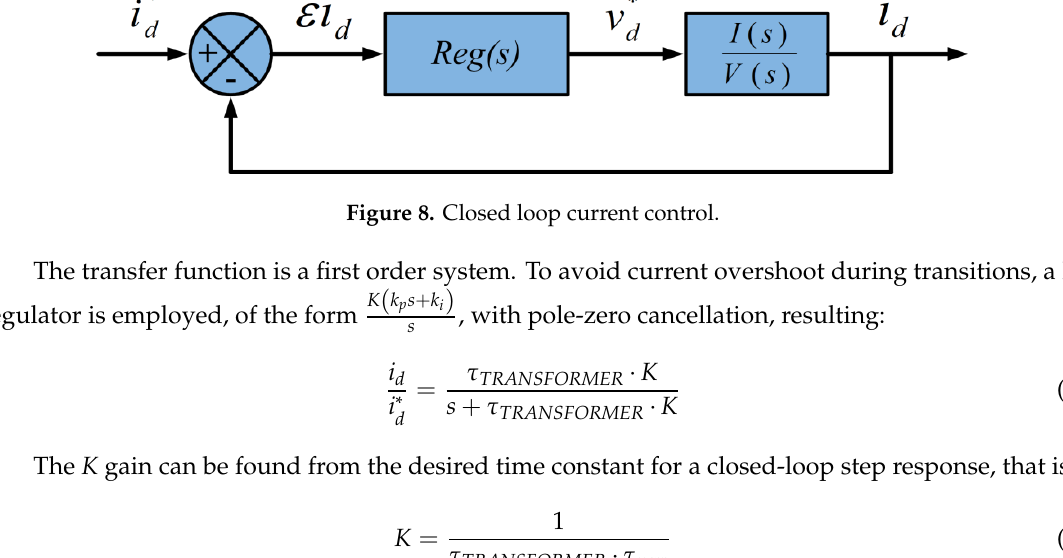
Figure 9. Block diagram of current harmonics generator.